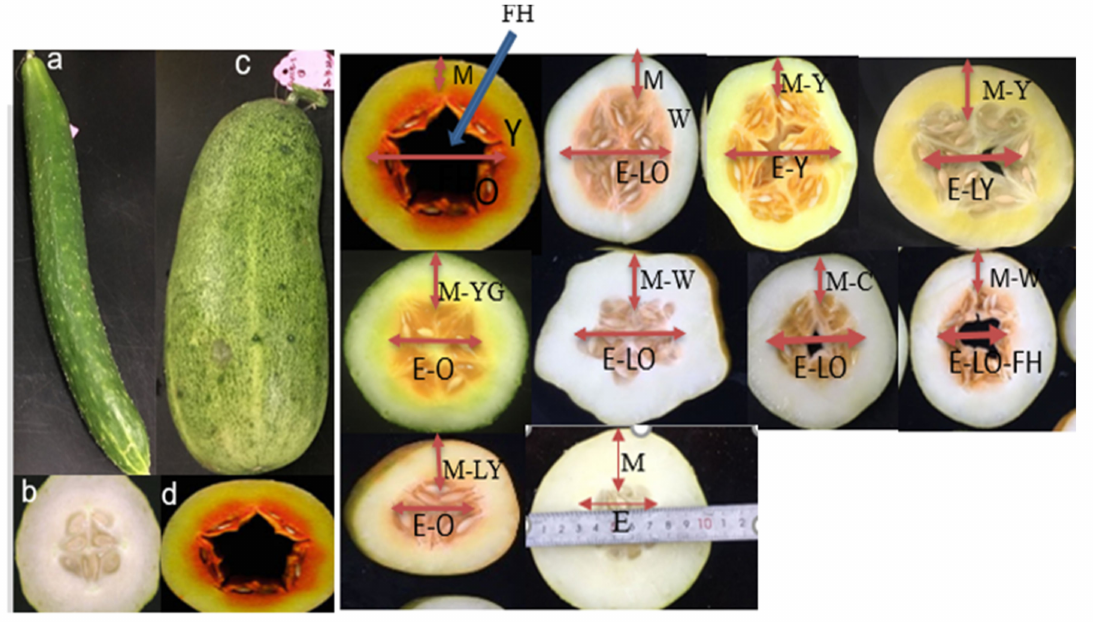
Figure 1. Morphological characteristics of ( a ) Chinese long inbred line and its ( b ) flesh color in comparison with ( c ) Xishuangbanna derived line and its ( d ) flesh color. Variation in mesocarp thickness, endocarp diameter, and the flesh colors of RIL-F 9 (SWCC8*CC3) mesocarp (M), endocarp (E), orange (O), yellow (Y), light orange (LO), light yellow (LY), yellow green (YG), cream (C), white (W), and fruit hollowness (FH); RIL-F9 (recombinant filial 9; SWCC8- South West China cultivar; CC3 Chinese long inbred